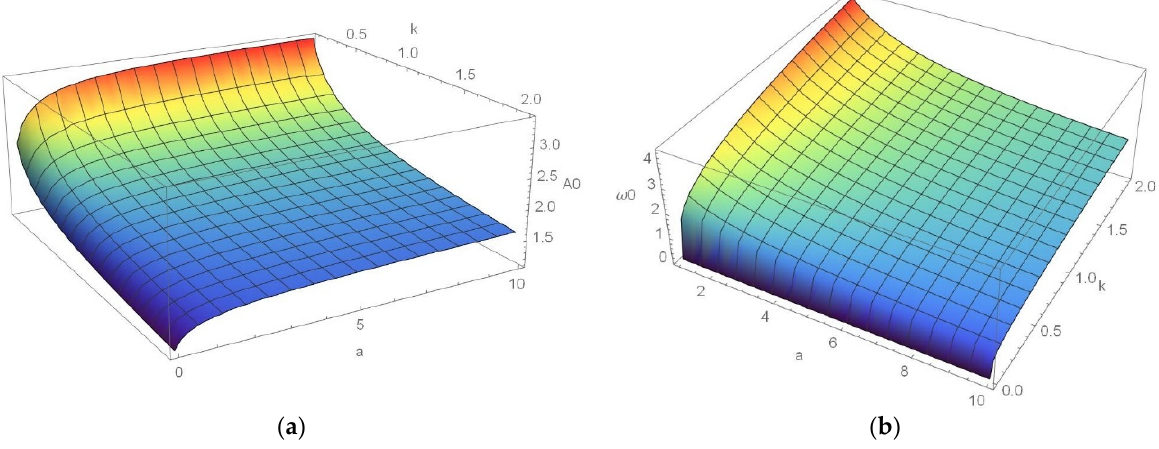
Figure 5. ( a ) A 0 - k - a and ( b ) ω 0 - k - a diagrams for constant α , F , b . In Figure 6, amplitude (a) and frequency (b) plots for various values of damping co- efficient and order of nonlinearity are plotted. Namely, in the amplitude interval A 0 = (0– 3) mm, frequency 𝜔 (cid:2868) = (0 − 4) mm and nonlinearity order α = 1–5, the A 0 - α - b and ω 0 - α - b diagrams for k = 1.5 N/mm 4 , F = 1.5 N and a/b = 10 are shown in Figure 6a,b, respectively.